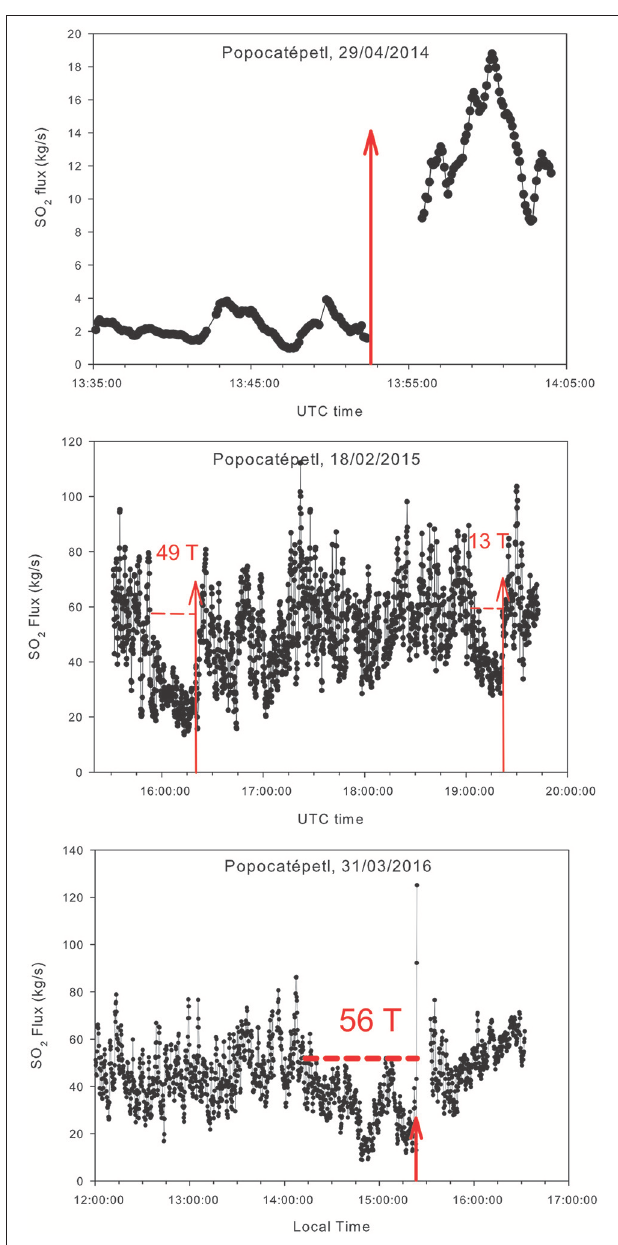
FIGURE 5 | SO 2 time series for the four E2-type explosions that we recorded so far. Except for the explosion of 29/04/2014, for which the SO 2 measurements started just 20min before the event and the flux decrease was probably missed, all the explosions share a common pattern, featuring a rapid decrease of the SO 2 flux 20–60min before the eruption, a period of low flux where gas accumulates and pressure builds up, and significantly higher post explosive flux values. The SO 2 mass accumulated before the explosions (whose time is indicated as the red arrow) is calculated by integrating the curve below the background flux (highlighted by the red dashed